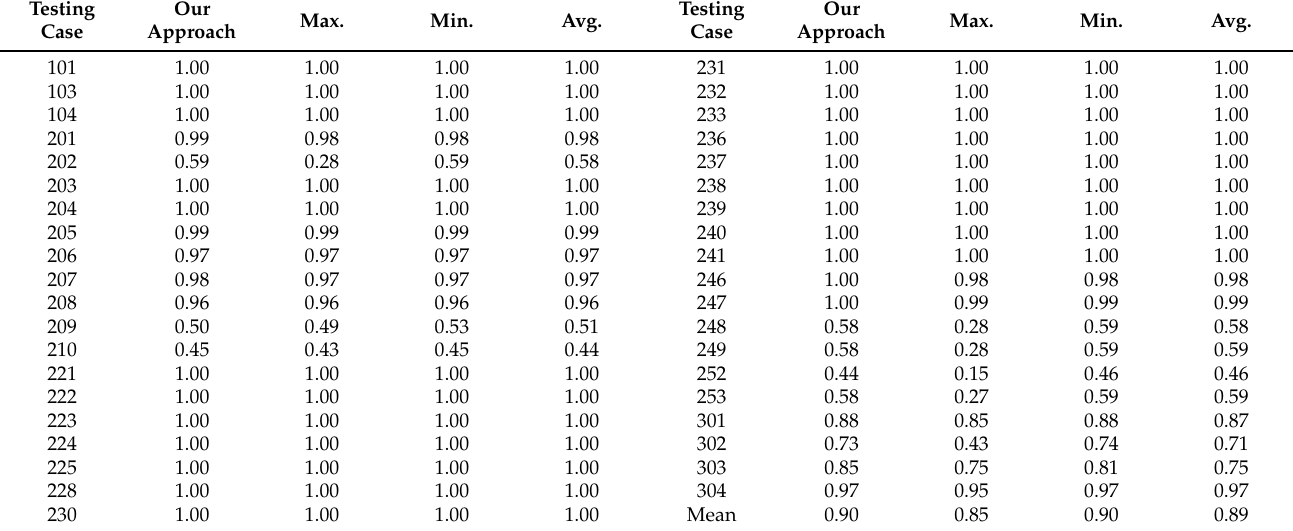
Table 10. Comparison Our Approach With Traditional Aggregation Methods On OAEI’s Benchmark.